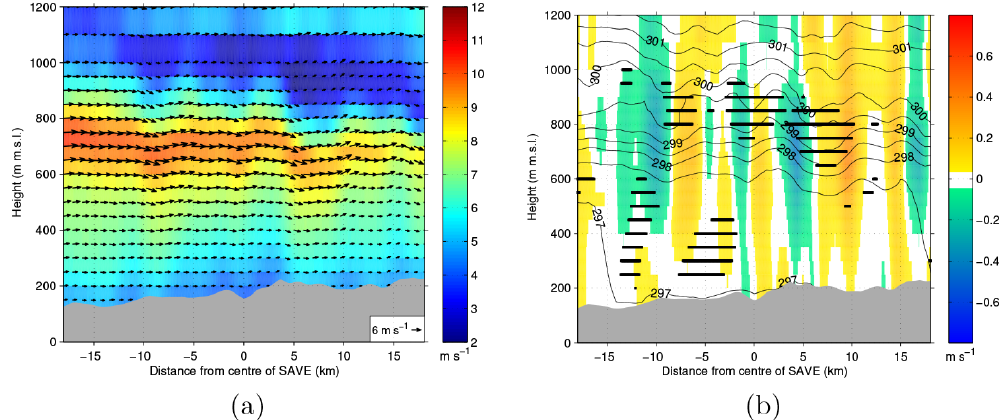
Figure 7. Vertical cross sections of horizontal wind speed (colour-coded) and flow components (horizontal and vertical (multiplied by 10); arrows) (a) and vertical wind speed (colour-coded) and potential temperature in K (black contours) (b) along a cross section through the centre of SAVE aligned along the mean wind direction of 207 ◦ at 00:00UTC. The mean wind direction was calculated for the layer below 1000mm.s.l. In (b) , black horizontal lines show areas with a turbulent kinetic energy higher than 0.5m 2 s − 2 . The grey shaded areas mark the terrain